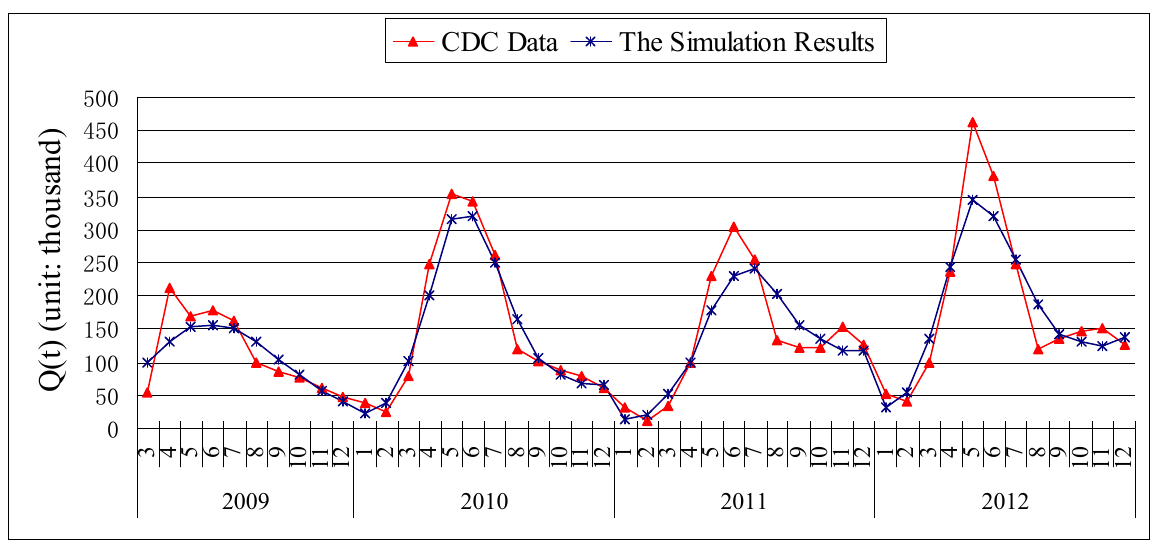
Figure 2. The comparison chart of the data of HFMD in China and simulation results by model